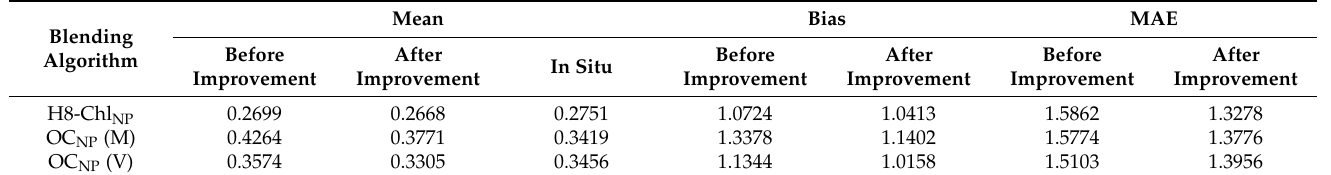
Table 8. Systematic deviation metrics of satellite Chl-a data before improvement and data based on